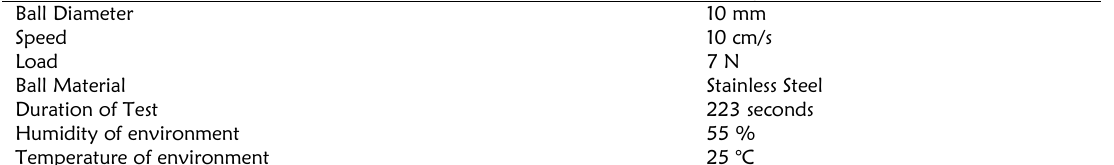
Table 3: Test parameters/conditions for tribology test